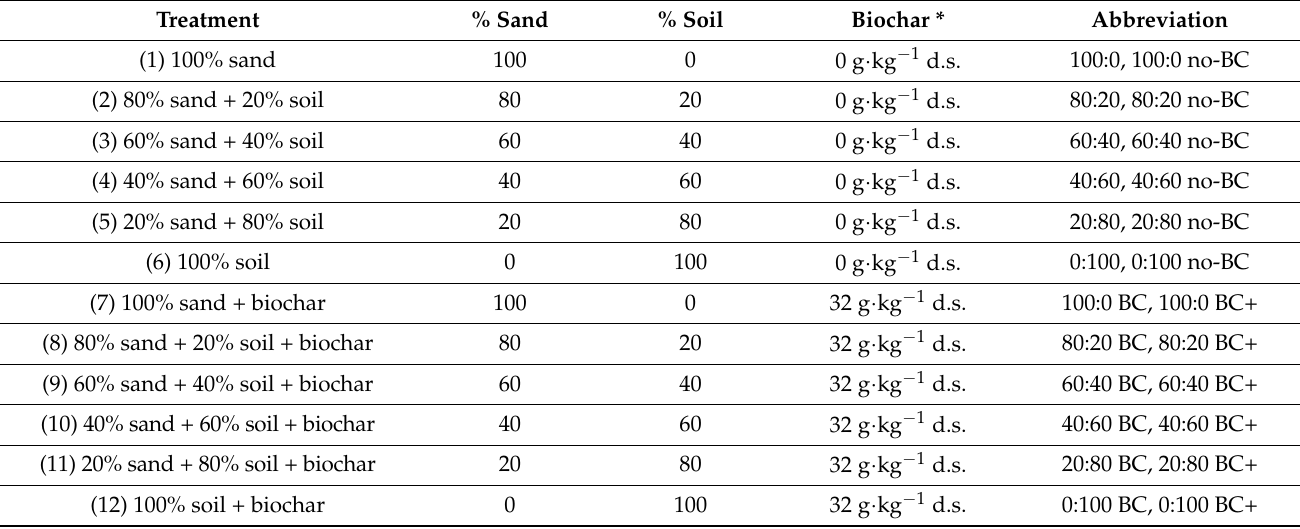
Table 1. Experimental treatments of soil and sand mixtures tested in the study. Treatment % Sand % Soil Biochar *